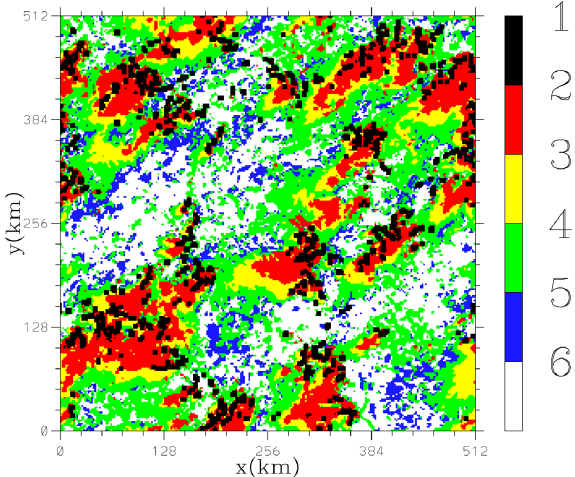
Fig. 1. Spatial distribution of six subgrid-scale categories over a domain of the sizes, 512km × 512km, simulated by a cloud- resolving model (CRM). The categories are (1) precipitating con- vection, (2) precipitating stratiform, (3) non-precipitating strati- form, (4) shallow clouds, (5) ice anvils, and (6) environment. The CRM simulation is from the TOGA-COARE (Tropical Ocean Global Atmosphere Couple Ocean Response Experiment) period, representing a typical fully-developed marine-type deep convective system. See Yano et al. (2005) for details of the simulations as well as the categorization scheme. (From Fig. 2a of Yano et al. (2005) with